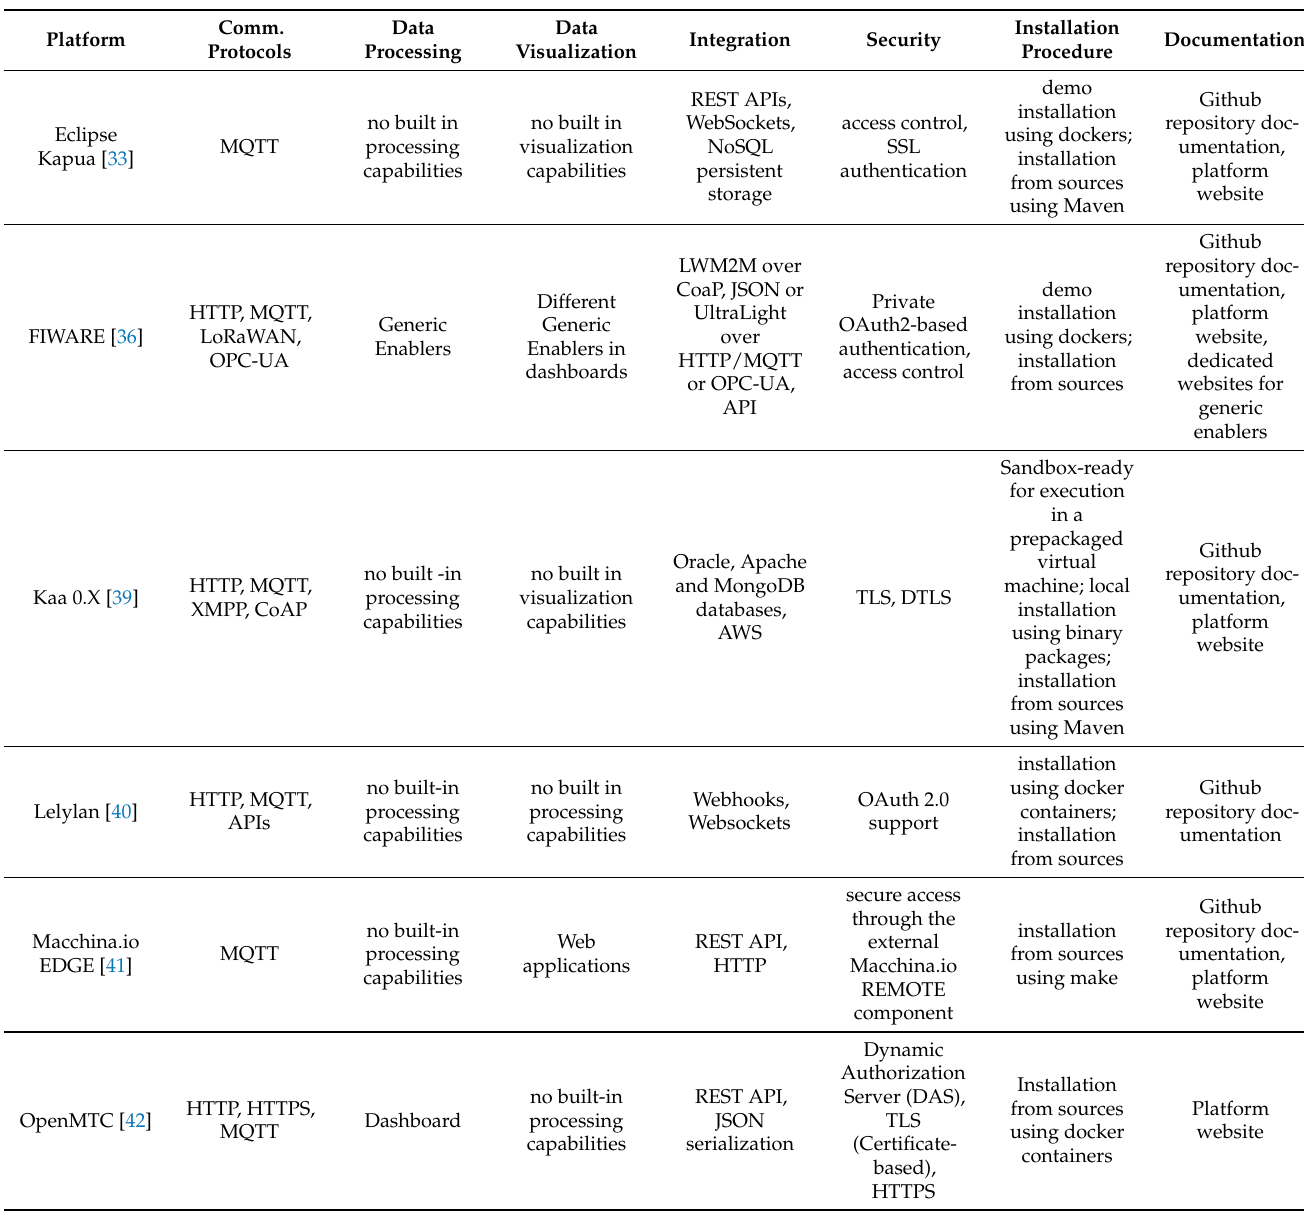
Table 2. Comparison of open source